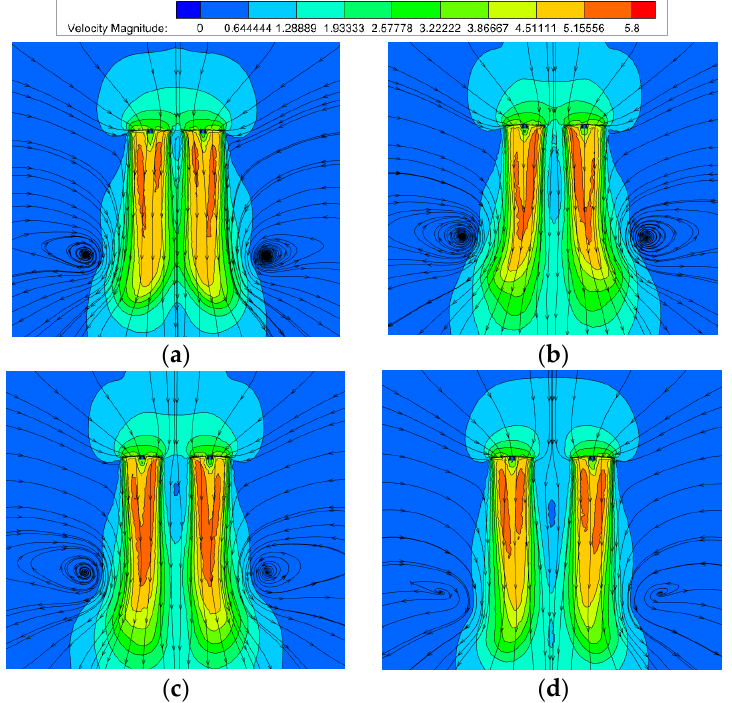
Figure 11. Velocity distribution. ( a ) rotor ‘1–5’; ( b ) rotor ‘2–6’; ( c ) rotor ‘3–7’; ( d ) rotor ‘4–8’.